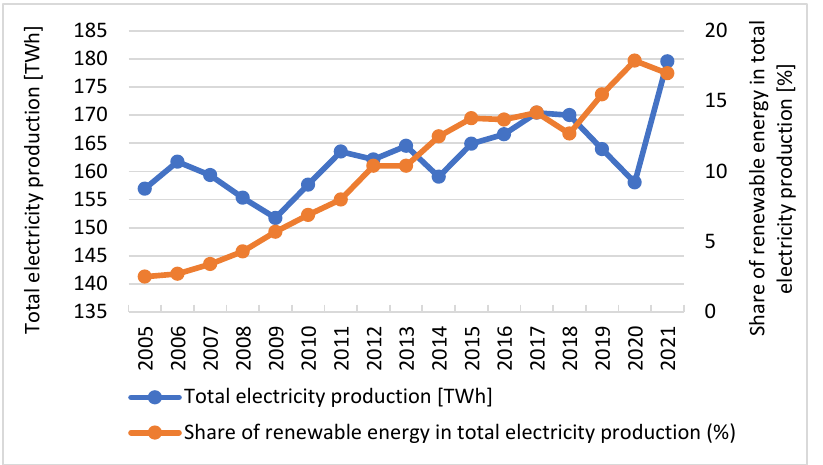
Figure 1. Total electricity production and share of renewable energy in Poland 2005 – 2021. Source: own elaboration on the basis of data from https://stat.gov.pl, accessed on 11 November 2022.